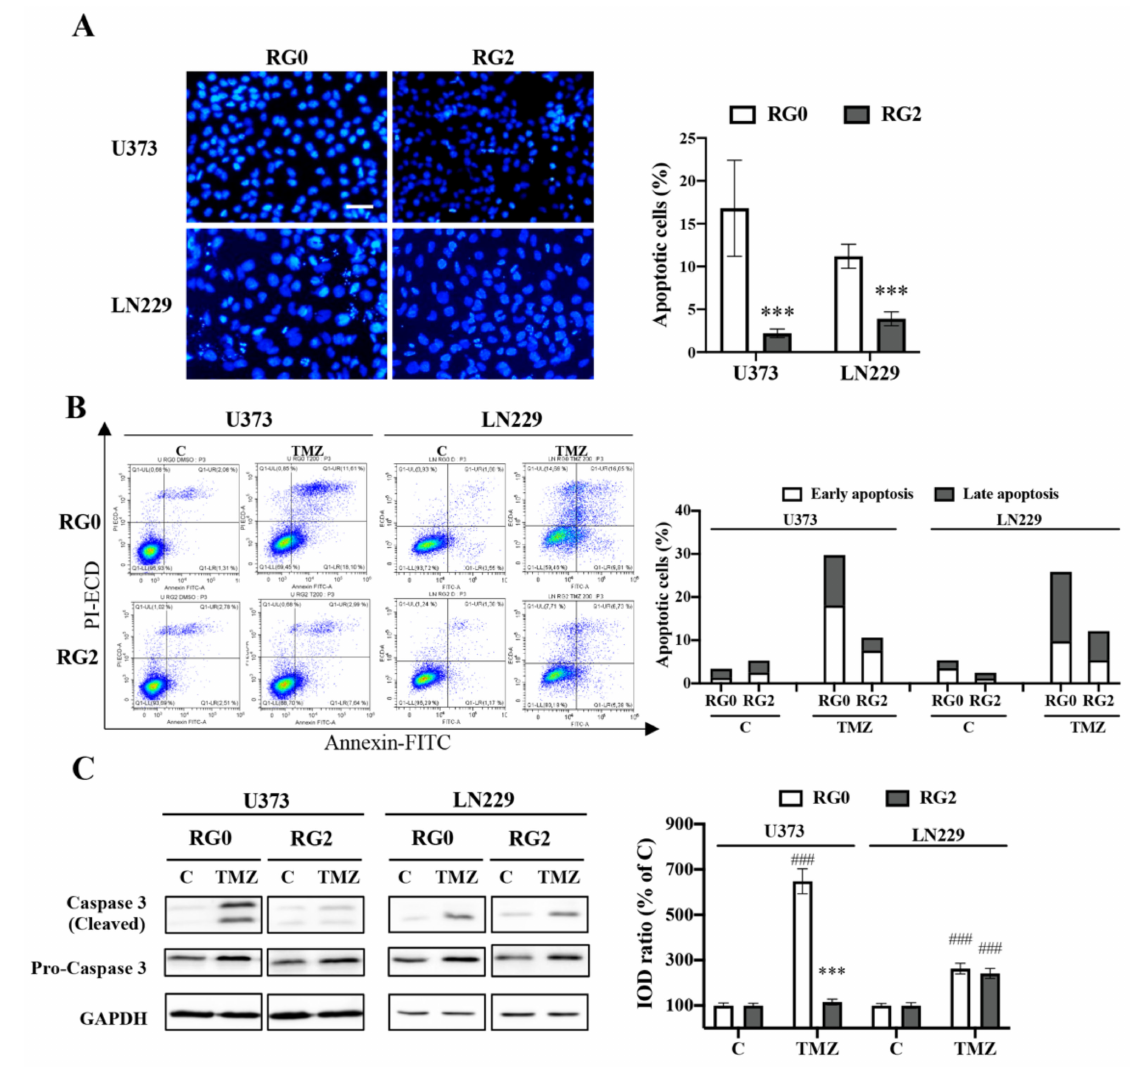
Figure 6. RG2 cells evaded TMZ-induced apoptosis. Apoptosis was evaluated in U373-RGs and LN229-RGs after 72 h of TMZ (150 µ M) treatment. ( A ) Apoptosis was detected by nuclear staining with Hoechst 33258. Cells exhibiting condensed chromatin or apoptotic bodies were counted as apoptotic cells. Quantitative analysis was performed in six random fields per well per group (in quadruplicate). Scale bar: 50 µ m. ***, p < 0.001, compared with RG0. ( B ) Apoptosis assay by staining with Annexin V/PI followed by flow cytometry. Dot plots show apoptotic populations in RGs of U373 and LN229 cells (left) after 72 h of treatment with TMZ (150 µ M) or vehicle. Bar graph shows the percentage of early and late apoptotic cells in total cells from the dot plots (right). ( C ) TMZ-induced caspase 3 activation was detected by western blot (left) and semi-quantitation (right). The results were reproduced in at least three independent experiments. ***, p < 0.001, compared with RG0. ###, p < 0.001, compared with a corresponding vehicle control ( C